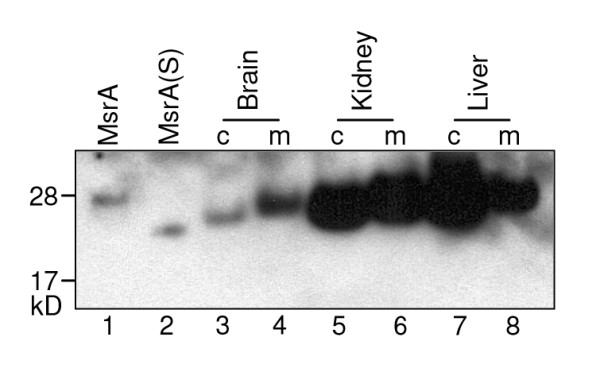
Western blot analysis of MsrA forms. Cytosolic and mitochondrial fractions from adult mouse brain, kidney, and liver [18] were used. Equal amounts (30 μg) of proteins were loaded on SDS-PAGE. Lanes 1 and 2, purified recombinant His-tagged mitochondrial MsrA and His-tagged MsrA(S); lanes 3 and 4, brain cytosolic and mitochondrial fractions; lanes 5 and 6, kidney cytosolic and mitochondrial fractions; lanes 7 and 8, liver cytosolic and mitochondrial fractions.